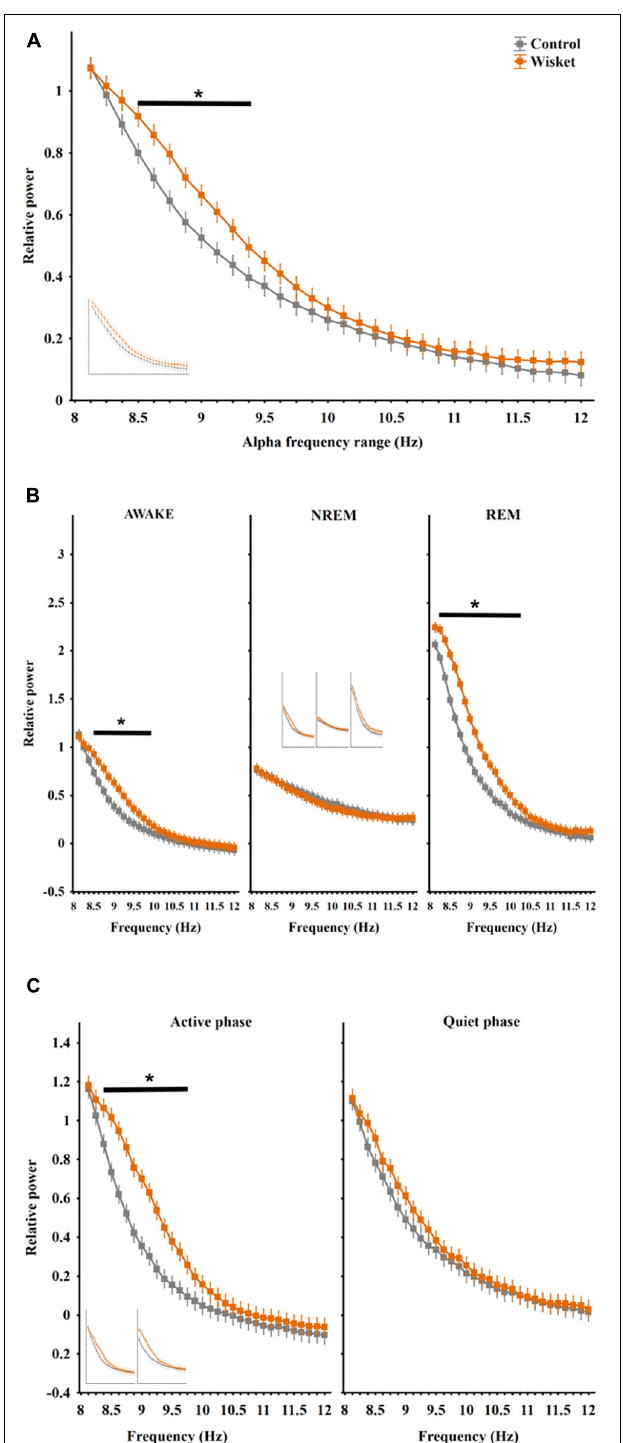
FIGURE 2 | Relative EEG power differences between the two groups at the alpha frequency band. (A) Total relative alpha power (8–12 Hz). (B) Alpha power in different stages panel. (C) Alpha power in active and quiet awake substages. Curves inserted in reduced size show the results obtained from unmatched control and Wisket animals. The symbol * shows significant ( p ◦ < ◦ 0.05) differences between the two